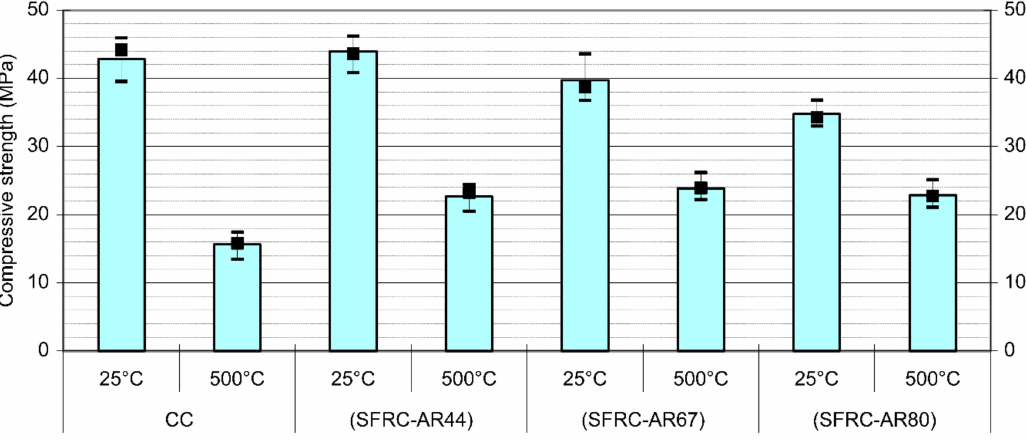
Figure 4. Compressive strengths of various concrete